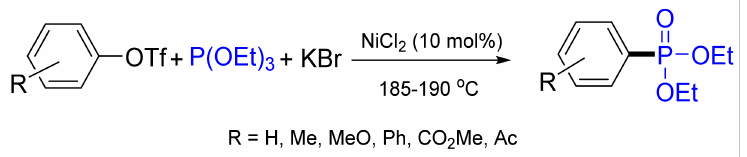
Figure 32. Nickel-catalyzed C-P cross-coupling of aryl triflates with triethyl